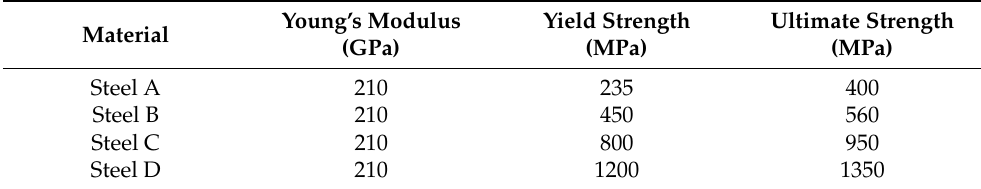
Table 2. Material properties of different steel material.